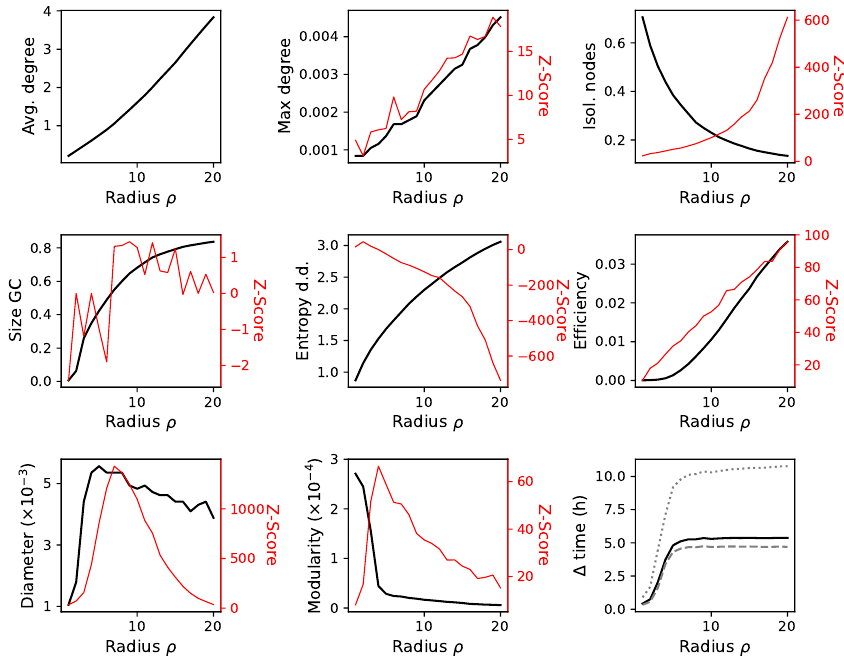
Figure A5. Statistics of the flights for 2018. From top to bottom, the five panels, respectively, report: the number of flights crossing the considered airspace; the distribution of the temporal resolution, i.e., of the time, in seconds, between available points, for planned and executed trajectories; and the distribution of the reported altitude, also for planned and executed trajectories. In the last four panels, black and red lines, respectively, correspond to planned and executed trajectories. Solid lines further correspond to the median of the daily value, dashed lines to the average, and bands to the 10–90 percentile.